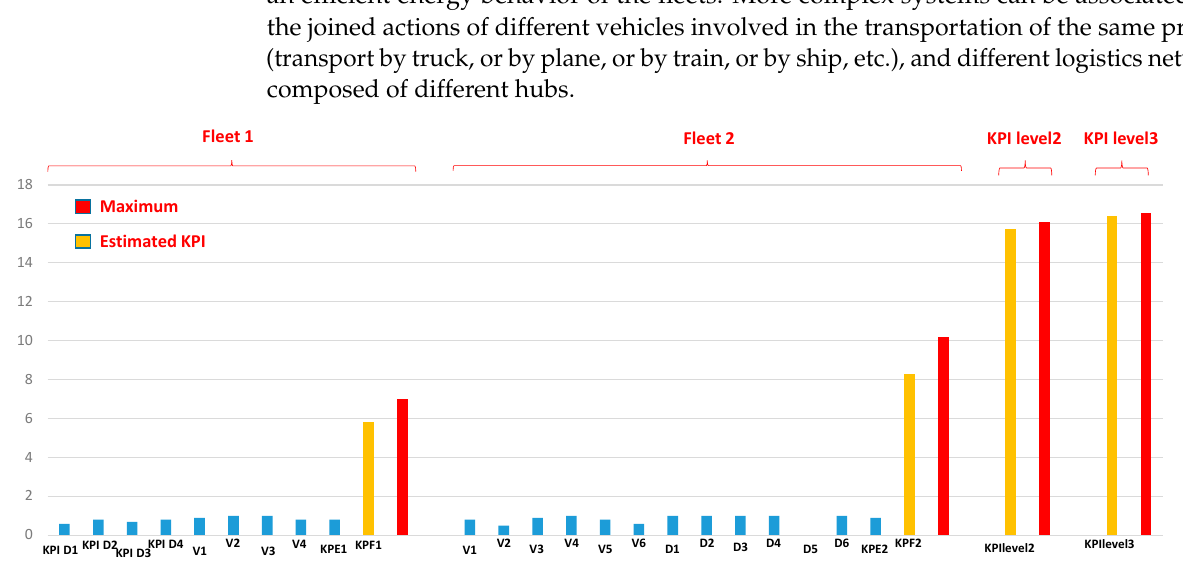
Figure A4. Example of KPI simulation related the model of Figure A3 using Equation (A1) for the calculated KPIs.